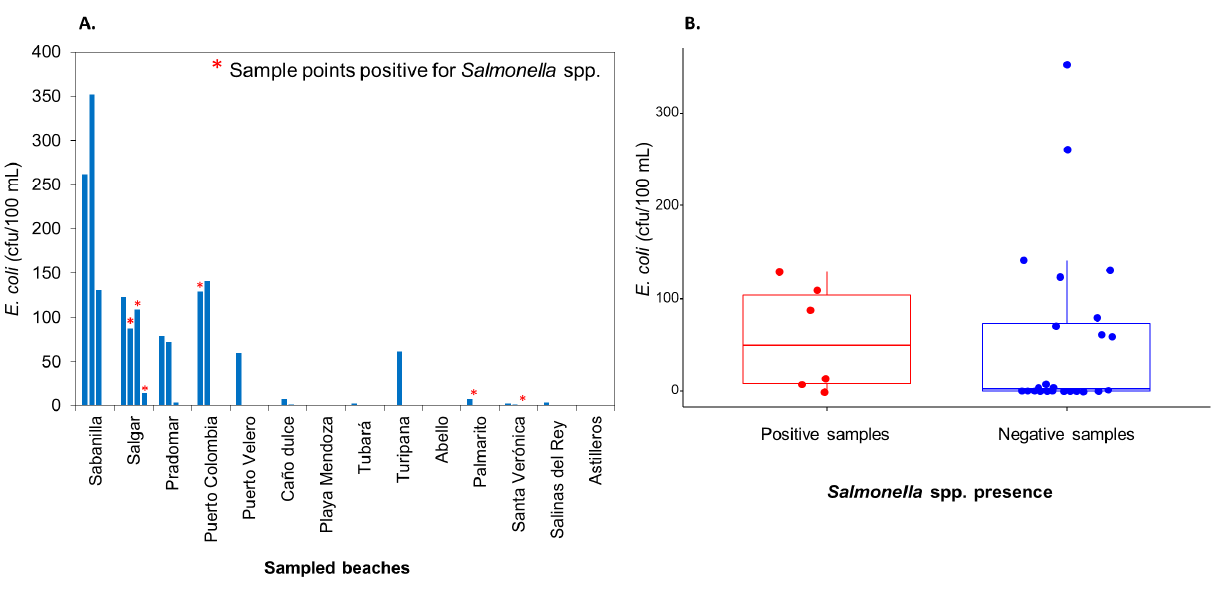
Figure 3. ( A ) Barplot representing E. coli count per each sampling point at beaches investigates. ( B ) Boxplot representing E. coli counts sorted according to their co-occurrence with Salmonella spp.